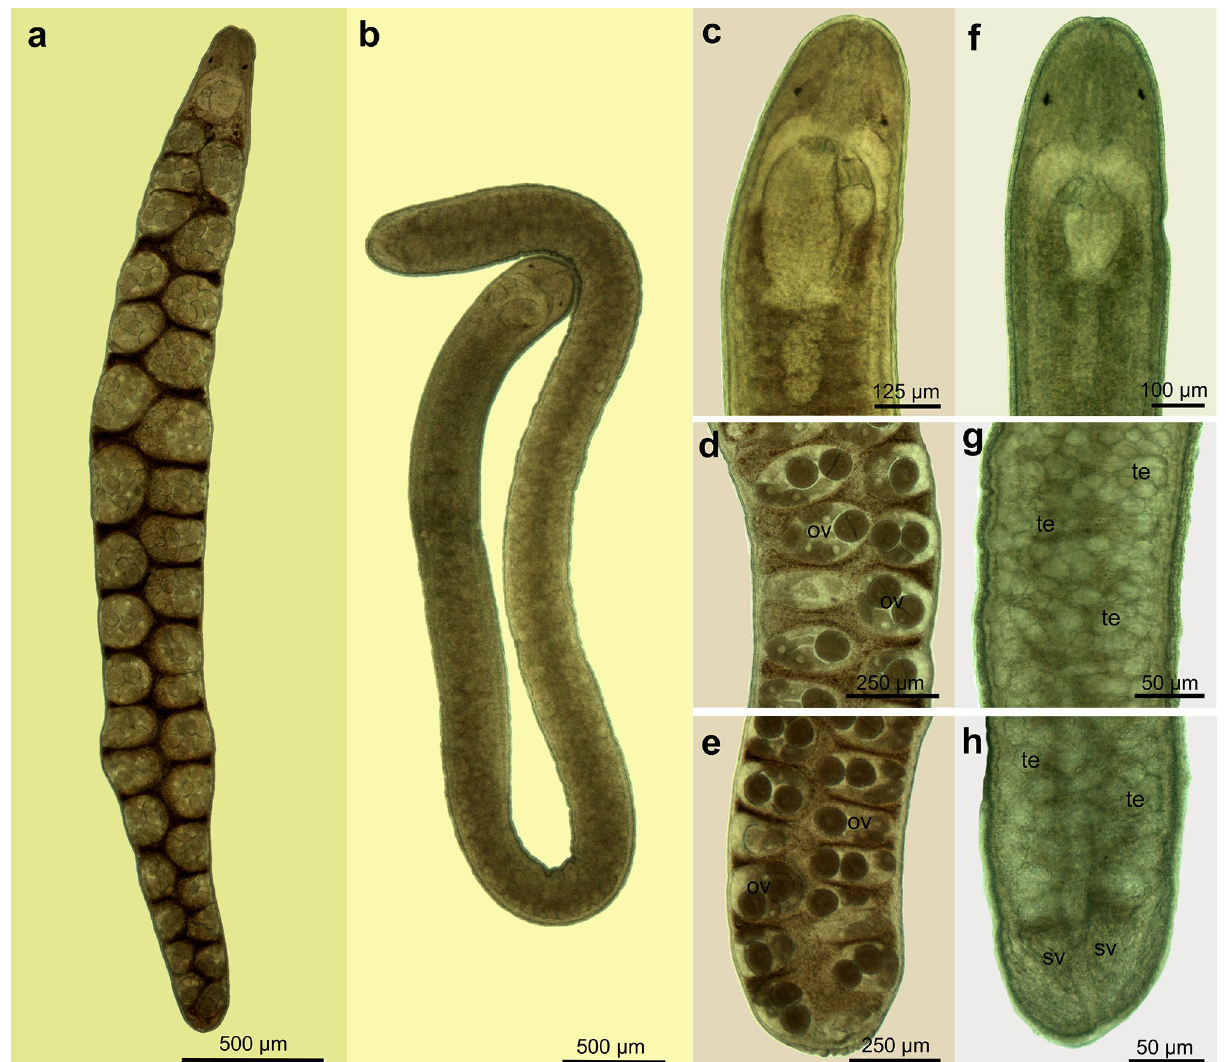
Figure 5. Photograph of complete worm of Carcinonemertes camanchaco sp. nov. ( a ) Complete female worm, ( b ) complete male worm; ( c ) anterior; ( d ) trunk and ( e ) posterior female body; ( f ) anterior; ( g ) trunk and ( h ) posterior male body. Body organs nomenclature is given in Fig.